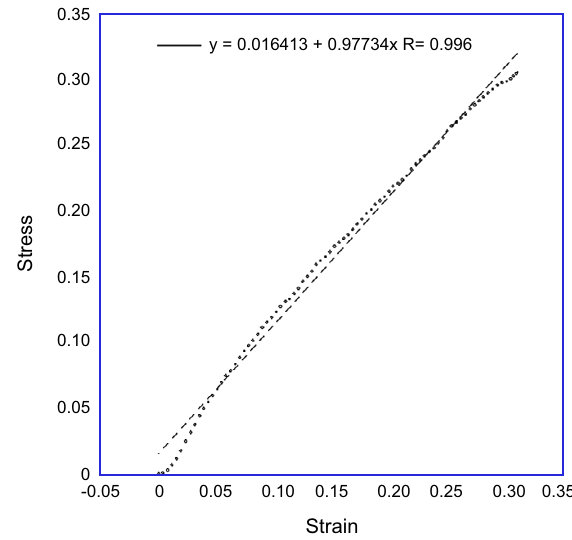
Figure 4. Graph showing Stress versus Strain in the undissected specimen in antero-posterior displacement biomechanical testing. Plotted line represents Young’s modulus, which is 0.977 MPa in this undissected